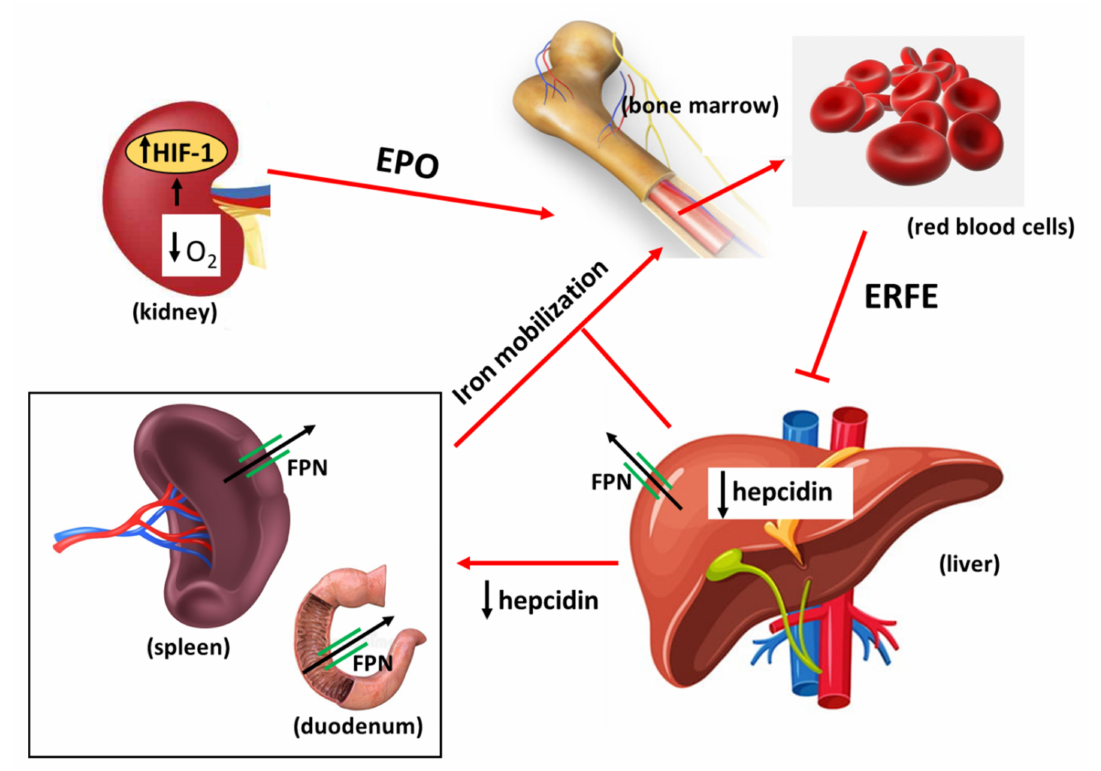
Figure 1. Major regulatory pathways involved in the effect of erythropoietic stimulation on the regulation of systemic iron